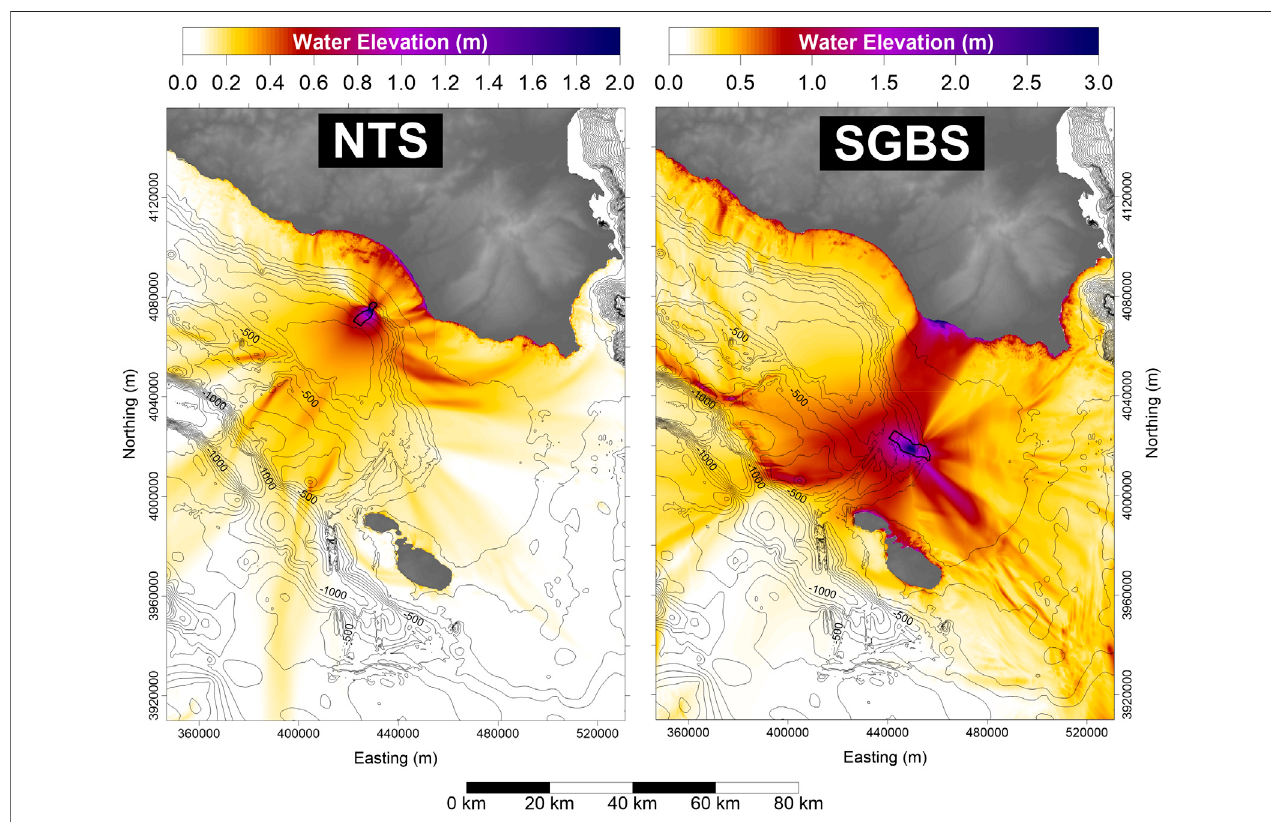
FIGURE 8 | Maximum water elevation for the two landslide scenarios, NTS (left) and SGBS (right) . The black boundaries mark the area swept by the landslide motion. Notice that the color scales cover different intervals for the two plots.